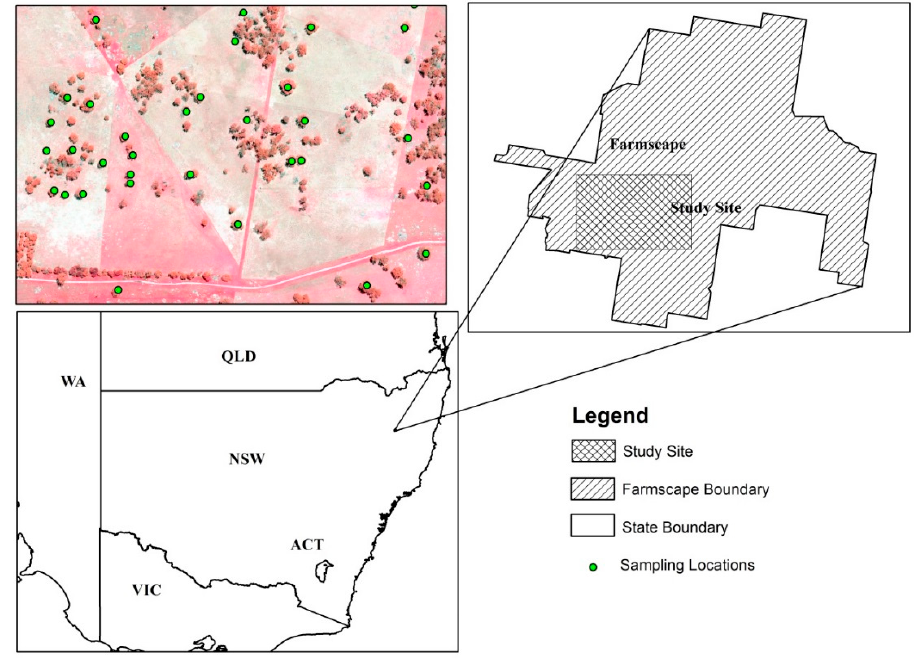
Figure 3. Location map of the study site in north-eastern NSW, Australia. Source: open access data.